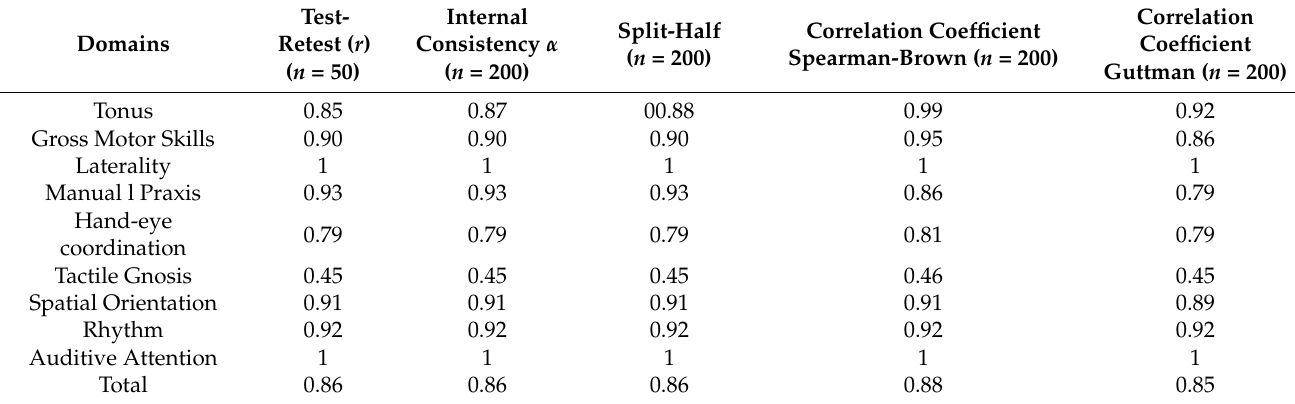
Table 4. NPmot.pt reliability indexes.